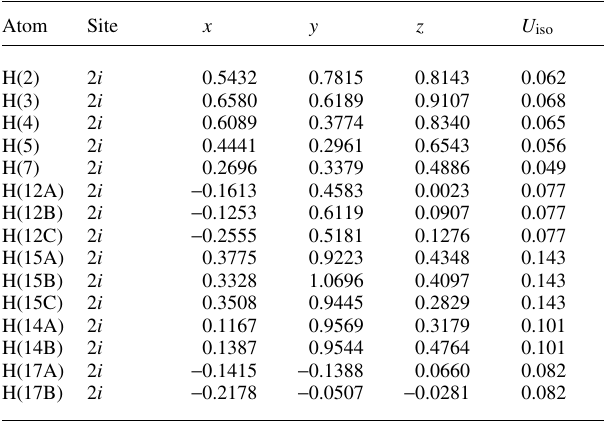
Table 2. Atomic coordinates and displacement parameters (in Å 2 )